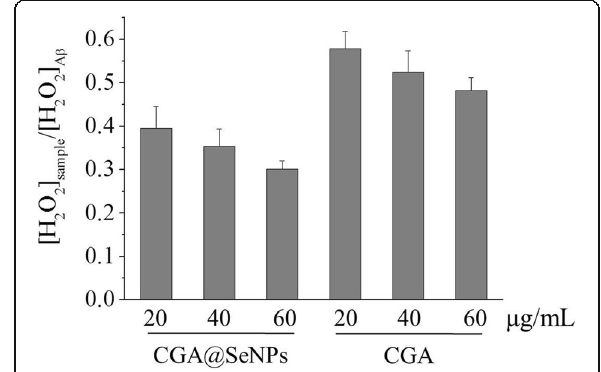
Fig. 2 H 2 O 2 generation from reactions of A β 40 in the presence or absence of nanoparticles. A β = 35 μ M, nanoparticles/CGA = 20, 40, and 60 μ g/mL